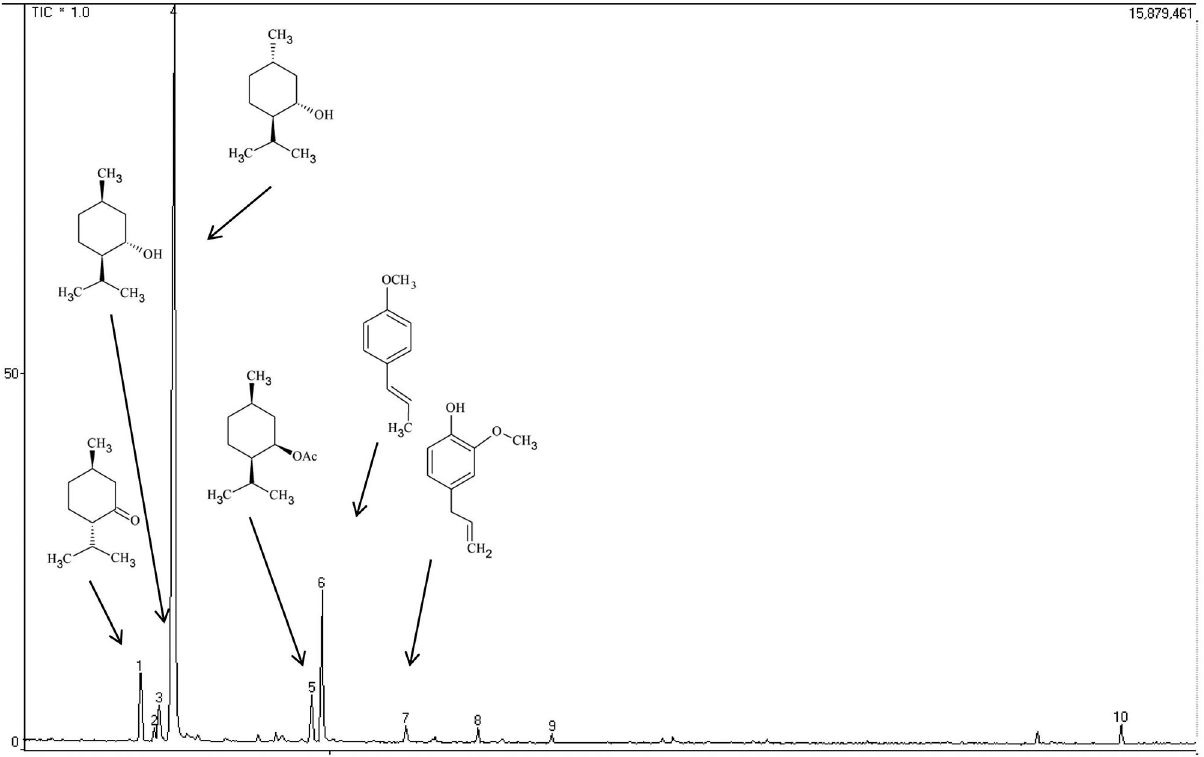
FIGURE 2 - Chromatogram obtained from gas chromatography of the non polar fractions obtained from Periogard ® . The determination of structures was performed with a mass spectrometer, and the results were compared with the NIST ® library as follows: menthone (retention time 1=7.82 min), menthol (retention time 3=8.03 min), isomenthol (retention time 4=8.21